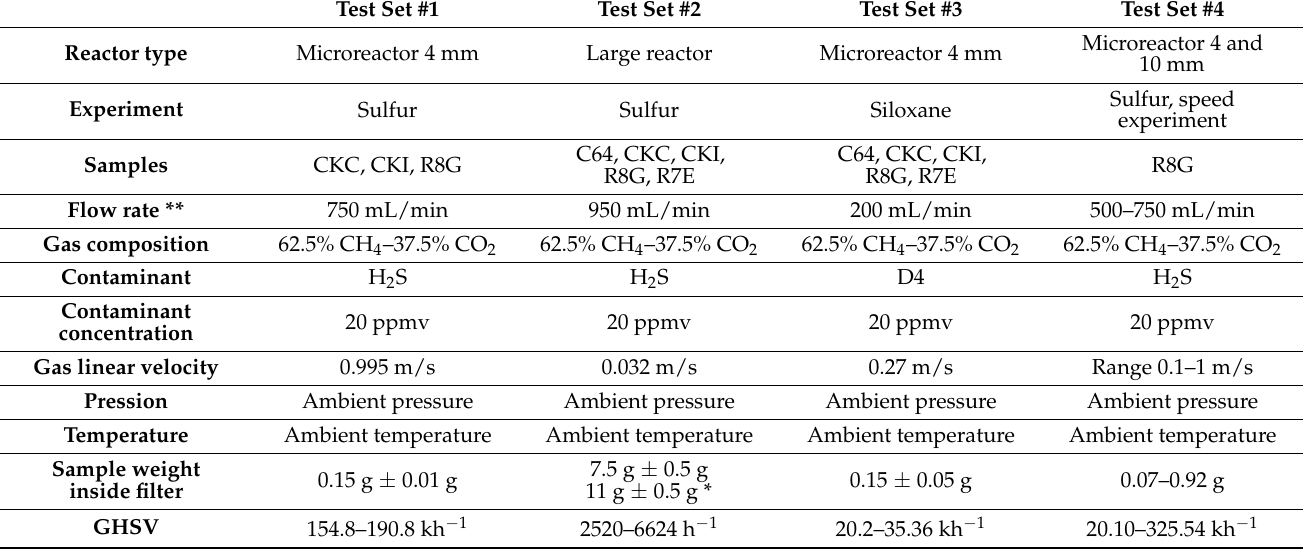
Table 1. Design of the experiments. * The R7E pellets were very irregular, so packing was not guaranteed with 7.5 g only because there were paths among the pellets. This caused preferential routes that led to a decreased filter performance. To solve this problem, the length of the filter was increased raising also the sample amount. The final R7E sample weight was 11.7 g. ** Normal conditions. Test Set #1 Test Set #2 Test Set #3 Test Set